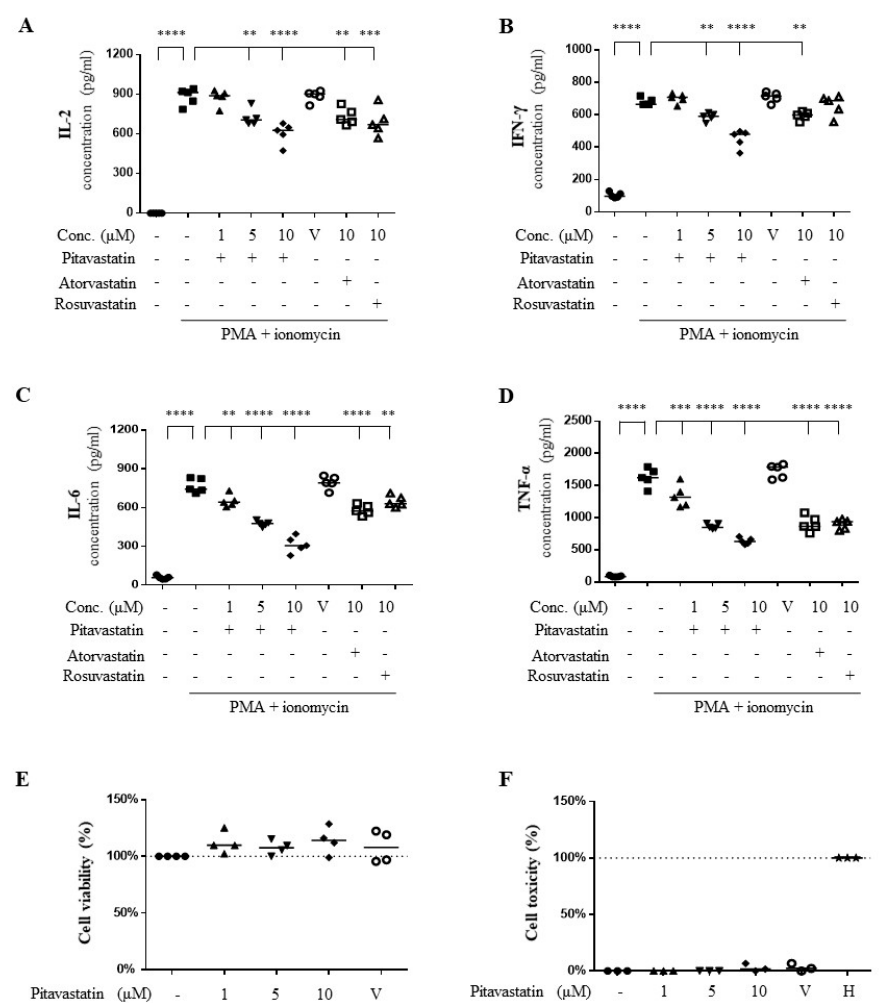
Figure 1. Pitavastatin suppressed pro-inflammatory cytokine production more than atorvastatin and rosuvastatin in phorbol 12-myristate 13-acetate (PMA) + ionomycin-activated primary T cells. ( A – D ) Human primary T cells were pretreated with indicated dose of pitavastatin (1, 5, and 10 µ M), 10 µ M atorvastatin, or 10 µ M rosuvastatin, respectively, for 2 h. Following 22 h of PMA (5 ng / mL) + ionomycin (1 µ M) stimulation, supernatants were collected for measuring interleukin (IL)-2 ( A ), interferon (IFN)- γ ( B ), IL-6 ( C ), and tumor necrosis factor α (TNF- α ) levels ( D ) by enzyme-linked immunosorbent assay (ELISA) methods. ( E , F ) Human primary T cells were treated with pitavastatin at the indicated concentrations for 24 h. The cells and cell-cultured supernatants were collected for 3-[4,5-dimethylthiazol-2-yl]-2,5-diphenyl tetrazolium bromide (MTT) assays ( E ) and lactate dehydrogenase (LDH) detection ( F ), respectively. V indicates vehicle control. H indicates the cells treated with 1% Triton X-100 as positive control (100% toxicity). Data were expressed as the median with individual data from 3–5 independent experiments. Significance were represented as ** p < 0.01, *** p < 0.001, and **** p < 0.0001 versus PMA + ionomycin-stimulated